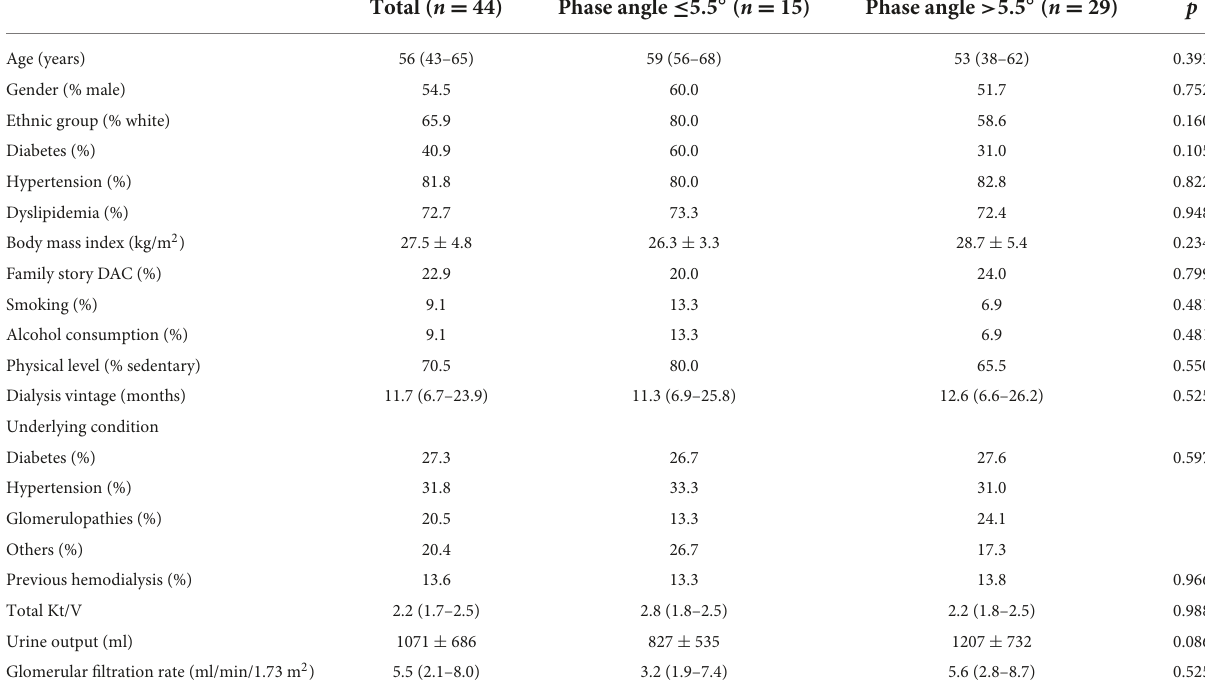
TABLE 1 General characteristics of peritoneal dialysis (PD) patients.